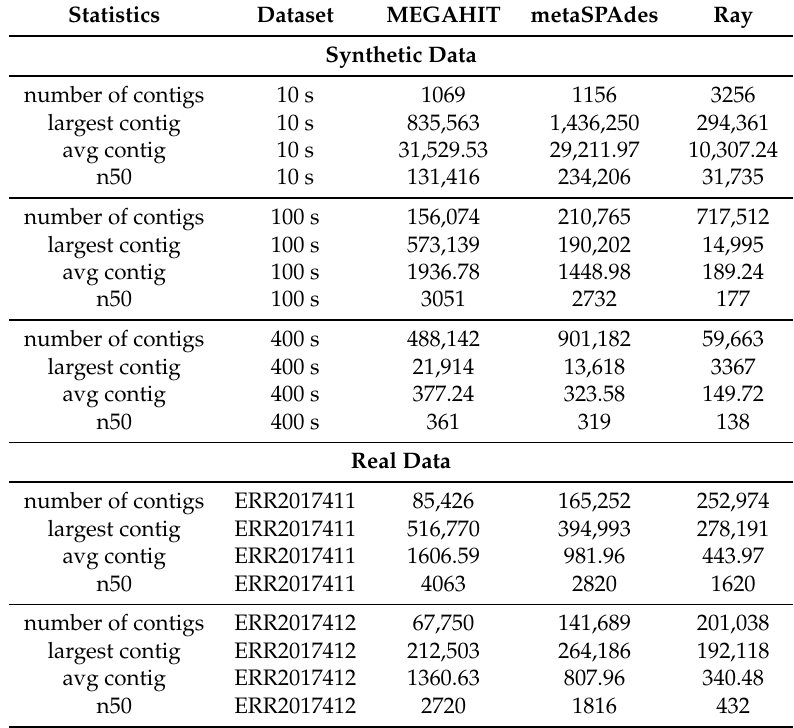
Table 2. Assembly statistics for all assemblers on simulated (10 s, 100 s, 400 s) and real (ERR2017411, ERR2017412) data.